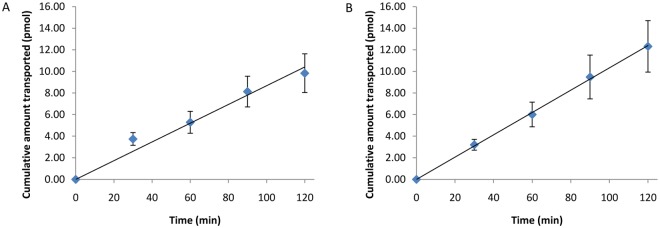
Intestinal permeability of quorum sensing peptide NWN.(A) Mean (n = 5) apical-to-basolateral transport (i.e. intestinal absorption) of the EDF-analogue (NWN) through a Caco-2 monolayer; (B) mean (n = 6) basolateral-to-apical transport (i.e. blood efflux) of the EDF analogue. Error bars represent SEM values.